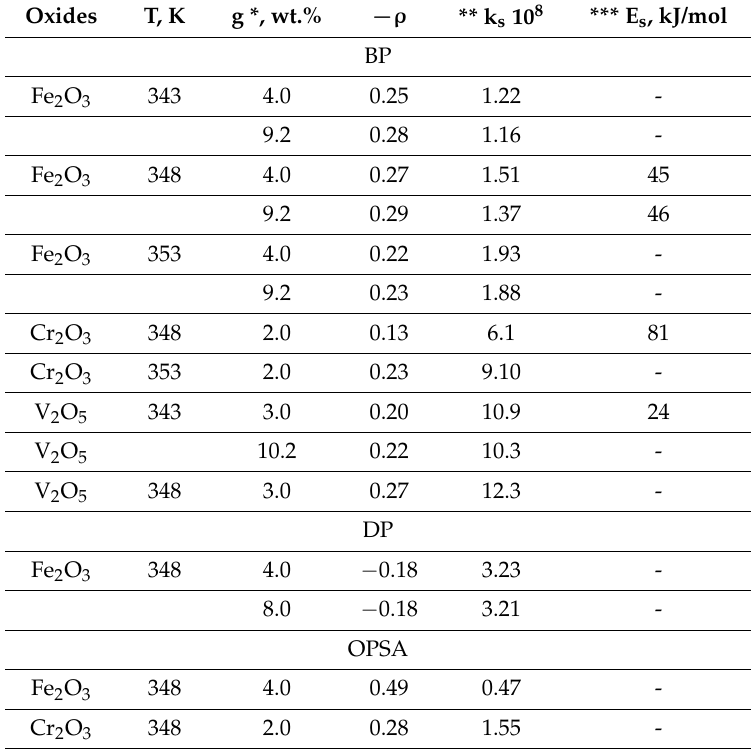
Table 5. The kinetic and activation parameters of the heterogeneous-catalytic decomposition of peroxides on oxides surface. Oxides T, K g *, wt.% − ρ ** k s 10